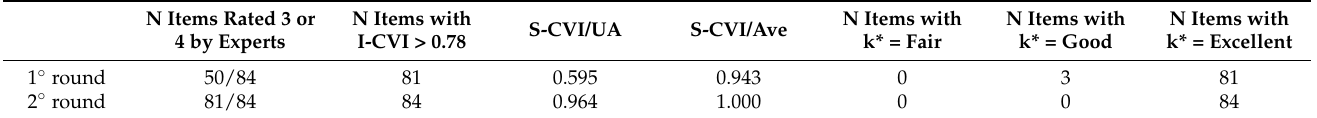
Table 1. Results of the two-round